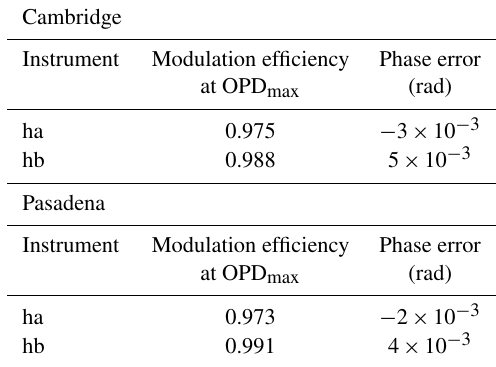
Table A1. Modulation efficiency and phase error determined for EM27/SUN ha and hb in Cambridge and Pasadena.